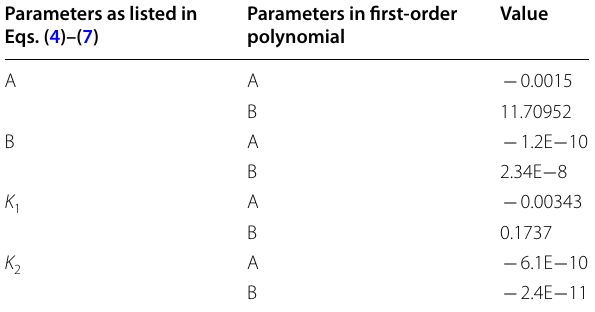
Table 3 Estimated values of parameters in Eqs. (4)–(7) Parameters as listed in Eqs. (4)–(7)